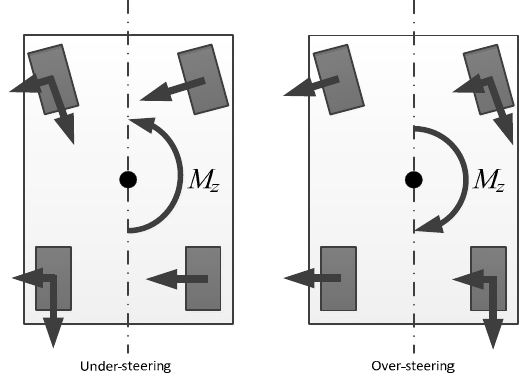
Figure 4. Correction yaw moment during left turn using brake.